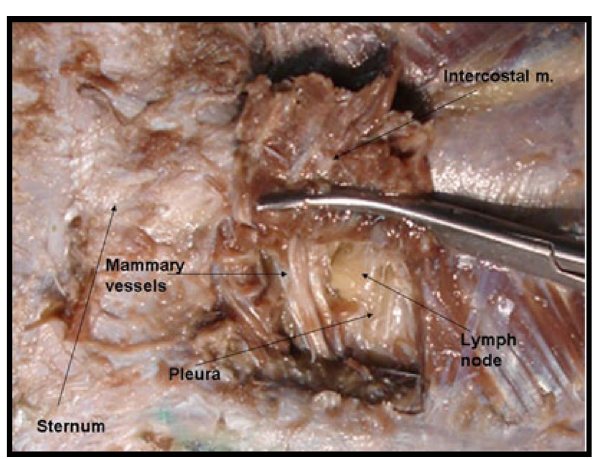
FIGURE 2 – Identification of the anatomical